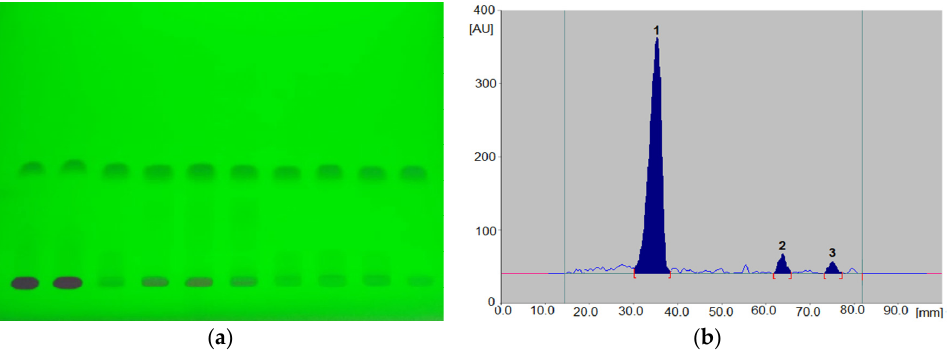
Figure 4. An example of the chromatogram ( a ) and densitogram ( b ; 1-grapiprant, 2,3-degradation products) for grapiprant solutions incubated 24 h at room temperature.